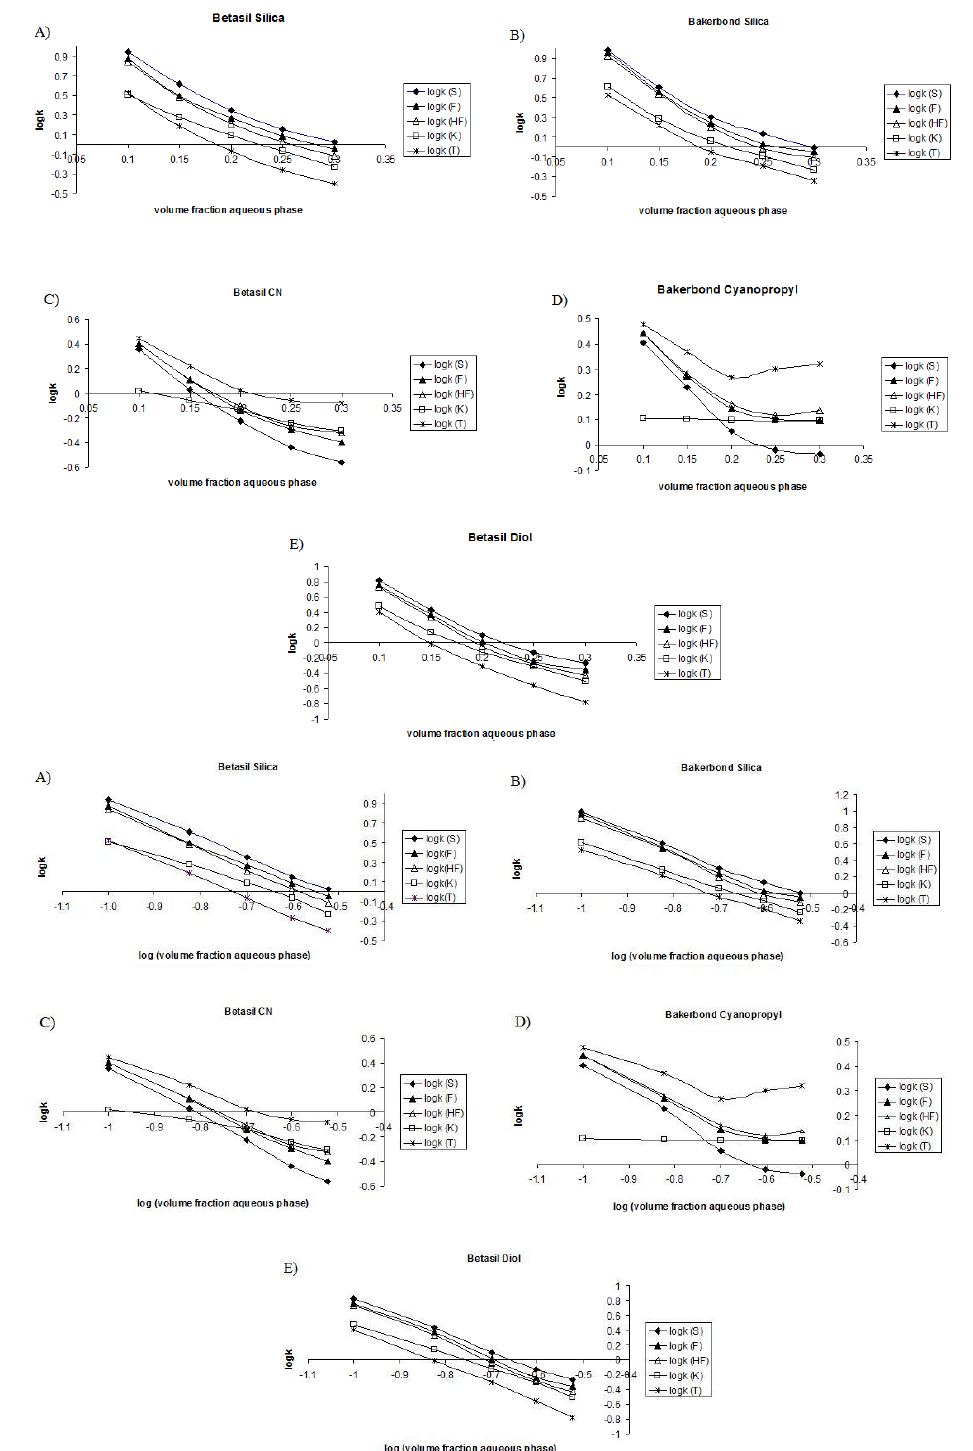
Figure 2. A) Plots of log k vs . volume fraction of the aqueous phase in the mobile phase and B) plots of log k vs . log volume fraction of the aqueous phase in the mobile phase. Solute identities: diamonds–sulpiride (S), full triangles–pheniramine (F), empty triangles–chlorpheniramine (HF), stars–clozapine (K), empty squares–thioridazine (T). Mobile phase: ACN–water in the range from (70:30 v/v) to (90:10 v/v) containing 20 mmol L -1 ammonium acetate pH 3.5. Chromatographic conditions: UV detection at 254 nm, column temperature 30°C, flow rate 1 mL min -1 . The column types are noted on top of each